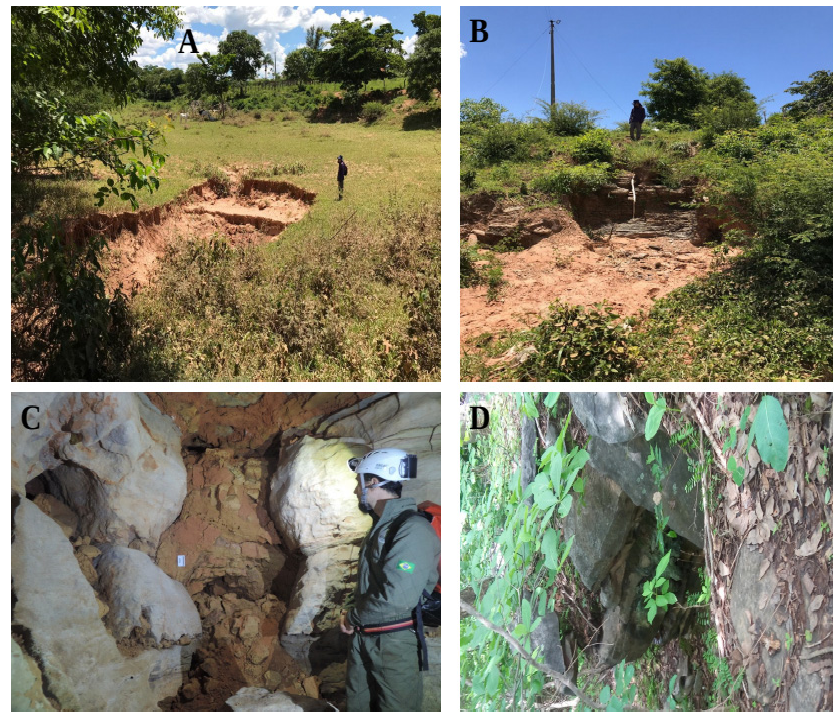
Figure 6. Site photographs taken near the ERT profiles. ( A ), ( B ) of the nearby APA02 sinkholes and an erosion site, ( C ) a buried duct in the carbonate rock and ( D ) surficial opening of the Tarimba cave lies near APA01 and GPR profiles.